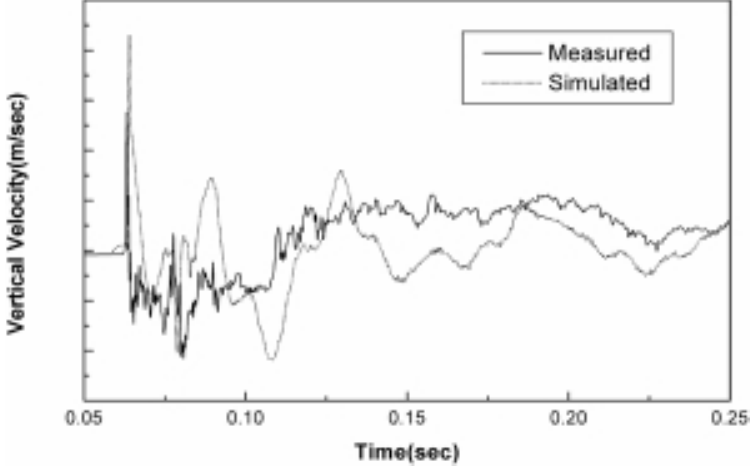
Fig. 13. Comparison of measured and simulated vertical velocity at bottom structure.